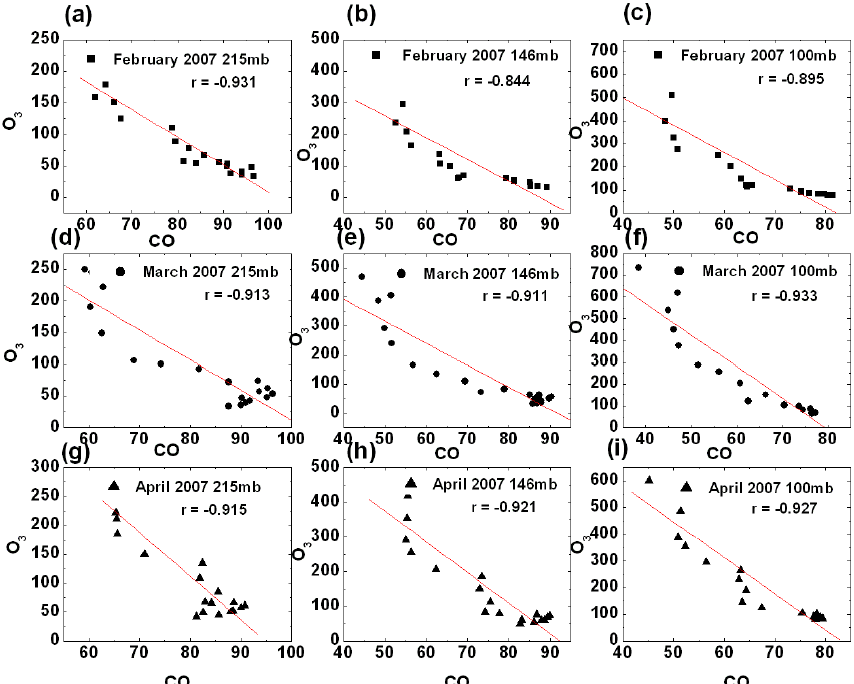
Fig. 3. Correlation between TES ozone and CO volume mixing ratio during (a) February 2007 at 215mb, (b) February 2007 at 146mb, (c) February 2007 at 100mb, (d) March 2007 at 215mb, (e) March 2007 at 146mb, (f) March 2007 at 100mb, (g) April 2007 at 215mb, (h) April 2007 at 146mb, (i) April 2007 at